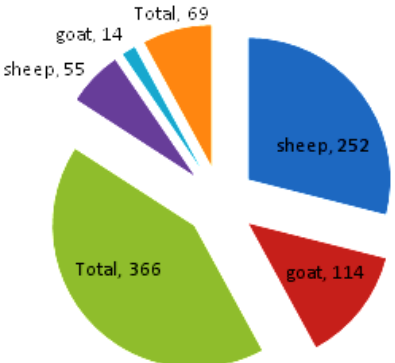
Fig.1: number of examined and infected